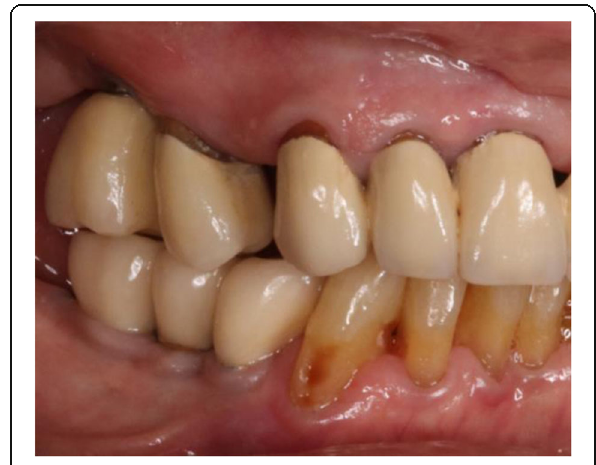
Fig. 12 Clinical follow-up of the same patient 8 years post-OP.